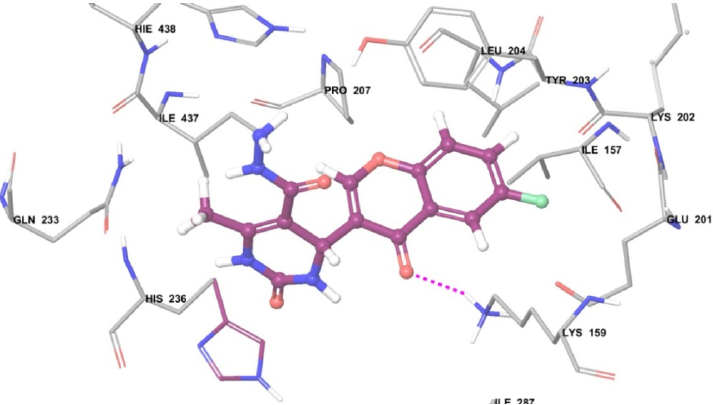
Figure 3. The docking pose of compound 6c into the active pocket of DdlB enzyme. (Pink bond represents the hydrogen bonding between ligand and receptor, Purple colored structure represents the molecule).